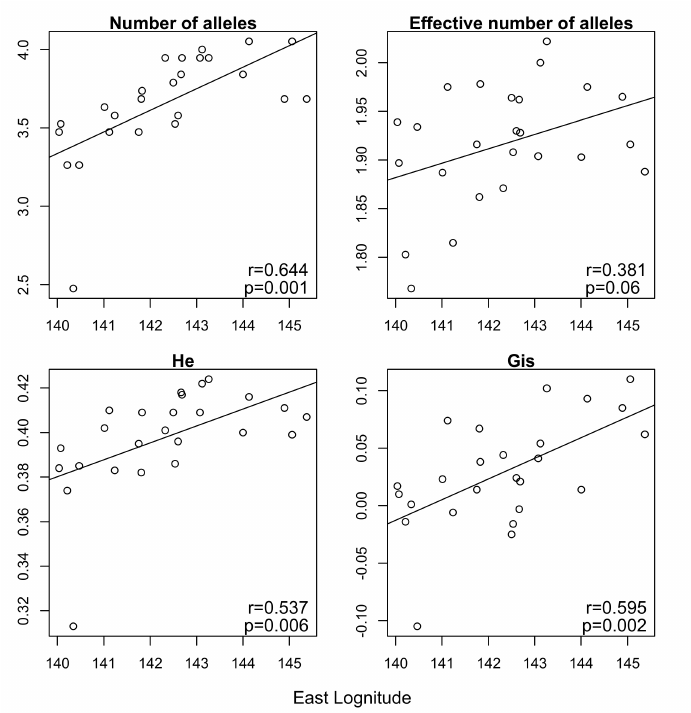
Figure 3. Relationships among genetic parameters and longitude east. Lines indicate the least